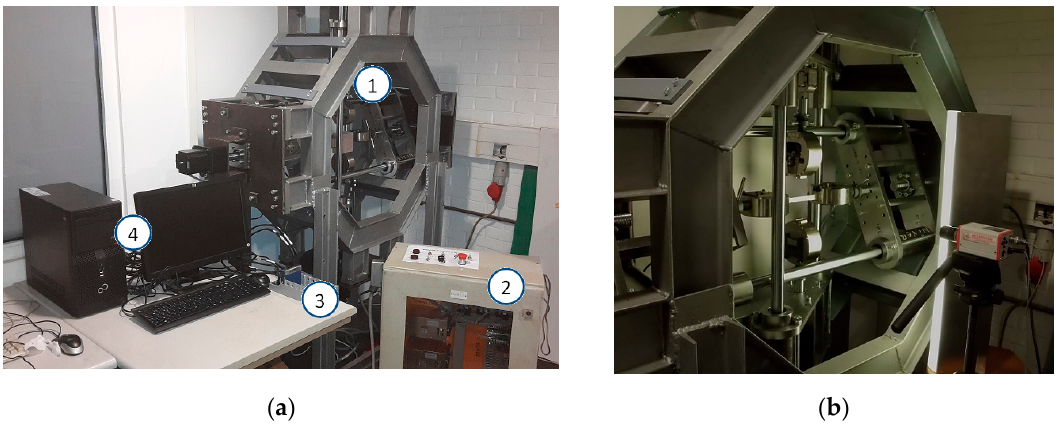
Figure 1. Biaxial testing machine: ( a ) (1) machine structure; (2) electrical panel; (3) acquisition system; and (4) computer for control; ( b ) Uniaxial tensile testing (horizontal axis) showing the video-extensometer system.